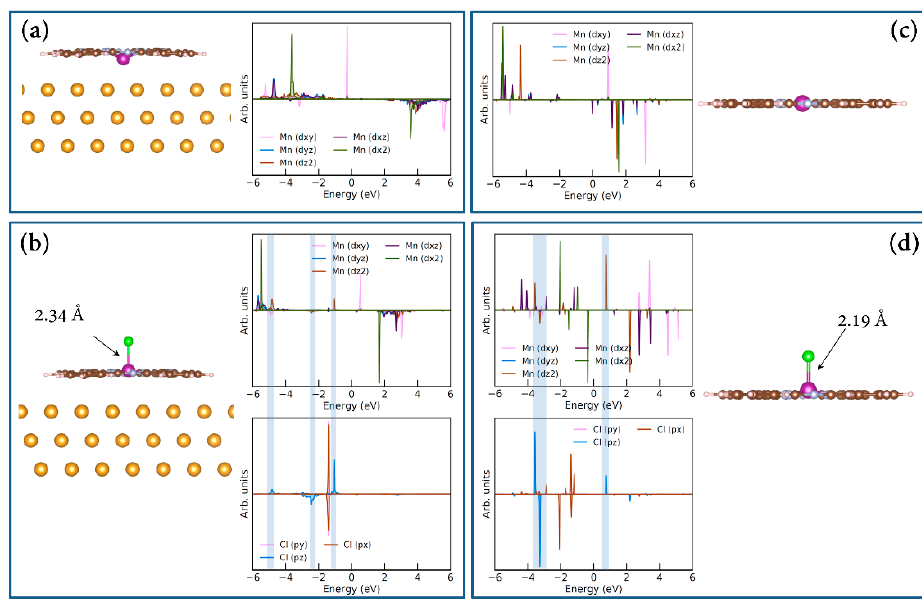
Figure 4. The results of DFT+ U calculations for MnPc and MnPcCl molecules. ( a ) Projected density of Mn d-states of MnPc adsorbed on Au(111), ( b ) projected density of Mn d-states and Cl p-states of MnPcCl adsorbed on Au(111), ( c ) projected density of Mn d-states of isolated MnPc, ( d ) projected density of Mn d-states and Cl p-states of isolated MnPcCl adsorbed on Au(111). Inset structures give side views of considered MnPc and MnPcCl molecules. For MnPcCl the overlap between Mn d z2 and Cl p z states is indicated. Fermi level was set to 0 eV.